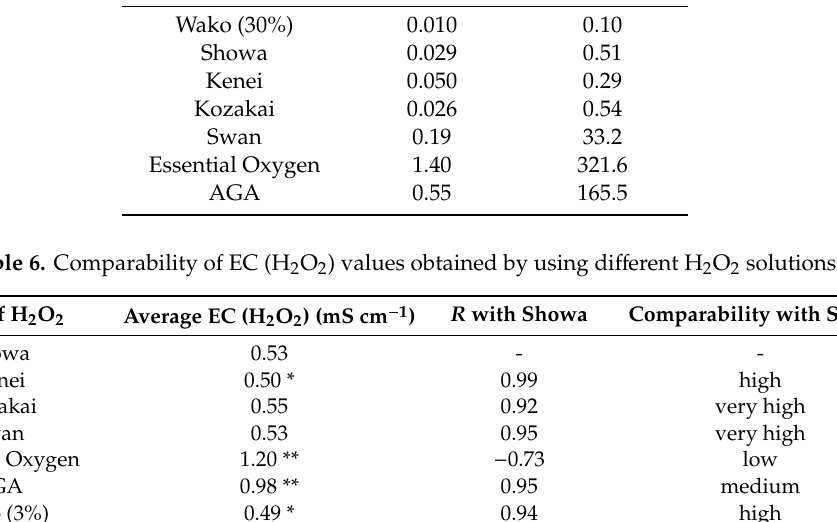
Table 5. EC values and Na concentrations of the different H 2 O 2 solutions used.